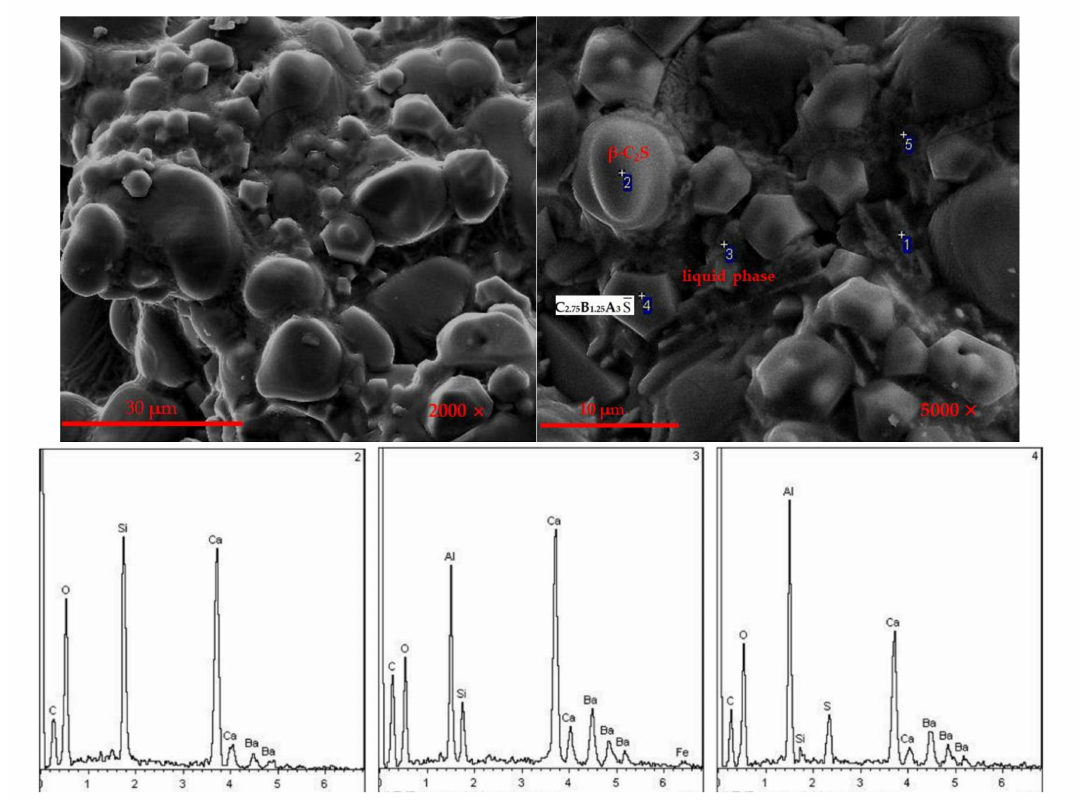
Figure 4. SEM-EDS photographs of CAF 3 clinker. Figure 5 is the SEM-EDS of the barium calcium sulfoaluminate cement clinker